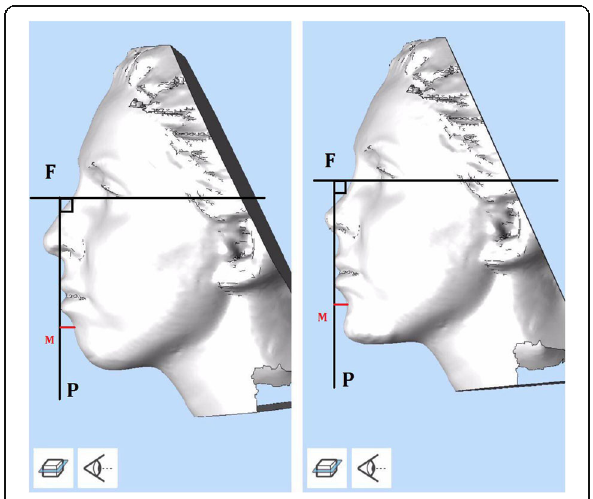
Fig. 4 Pre (left) and post-surgical (right) 3D scan views; patient undergoing Balcony genioplasty and rhinoplasty; F, Frankfurt plane; P, perpendicular line to the Frankfurt plane; M, depth of the mentolabial